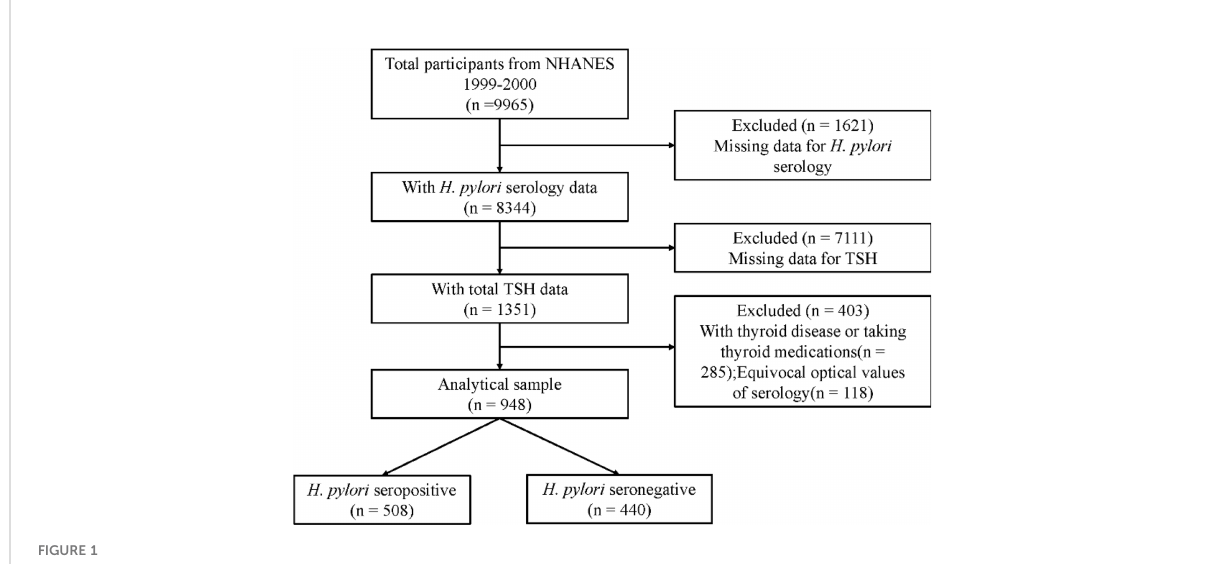
FIGURE 1 The sample selection fl ow